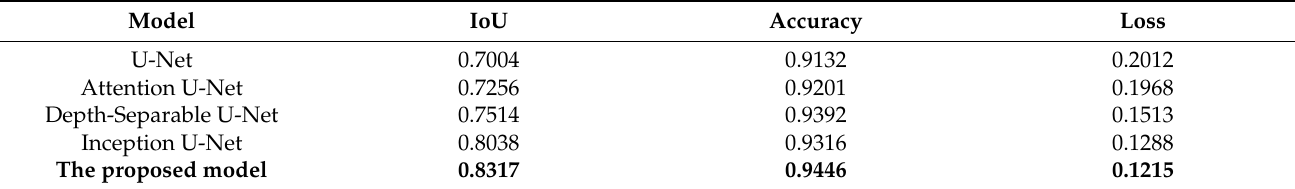
Table 2. Performance Evaluations of the Segmentation Models on the Sinkhole